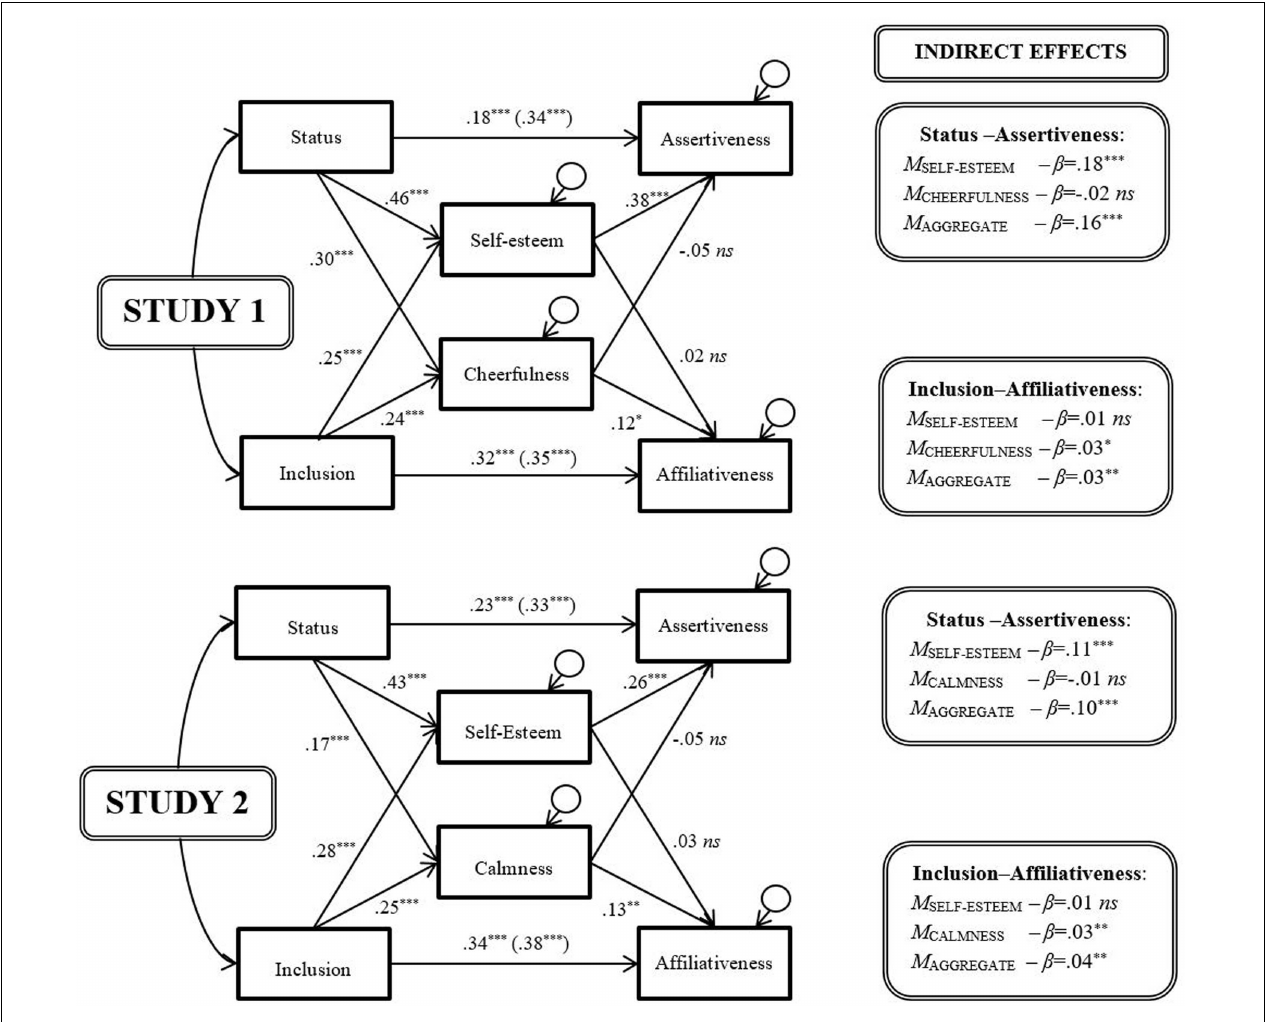
FIGURE 4 | The mediating effects of self-esteem and cheerfulness/calmness. † p < 0.10; ∗ p < 0.05; ∗∗ p < 0.01; ∗∗∗ p <